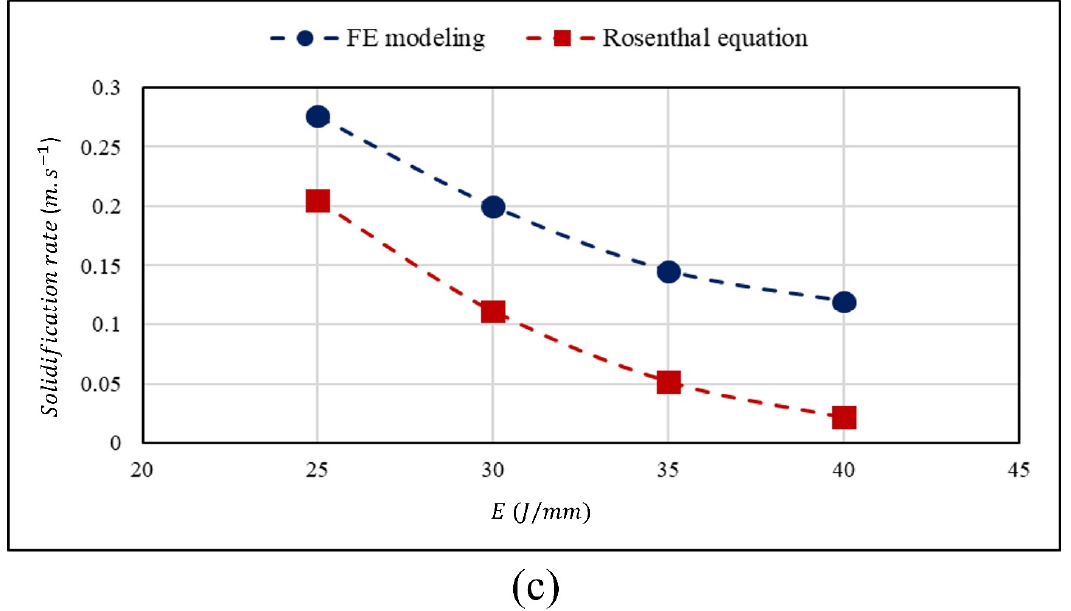
Figure 9. ( a ) Temperature gradient, ( b ) cooling rate, and ( c ) solidification rate achieved from the numerical modeling and the analytical method versus heat input of the laser beam and their comparison.